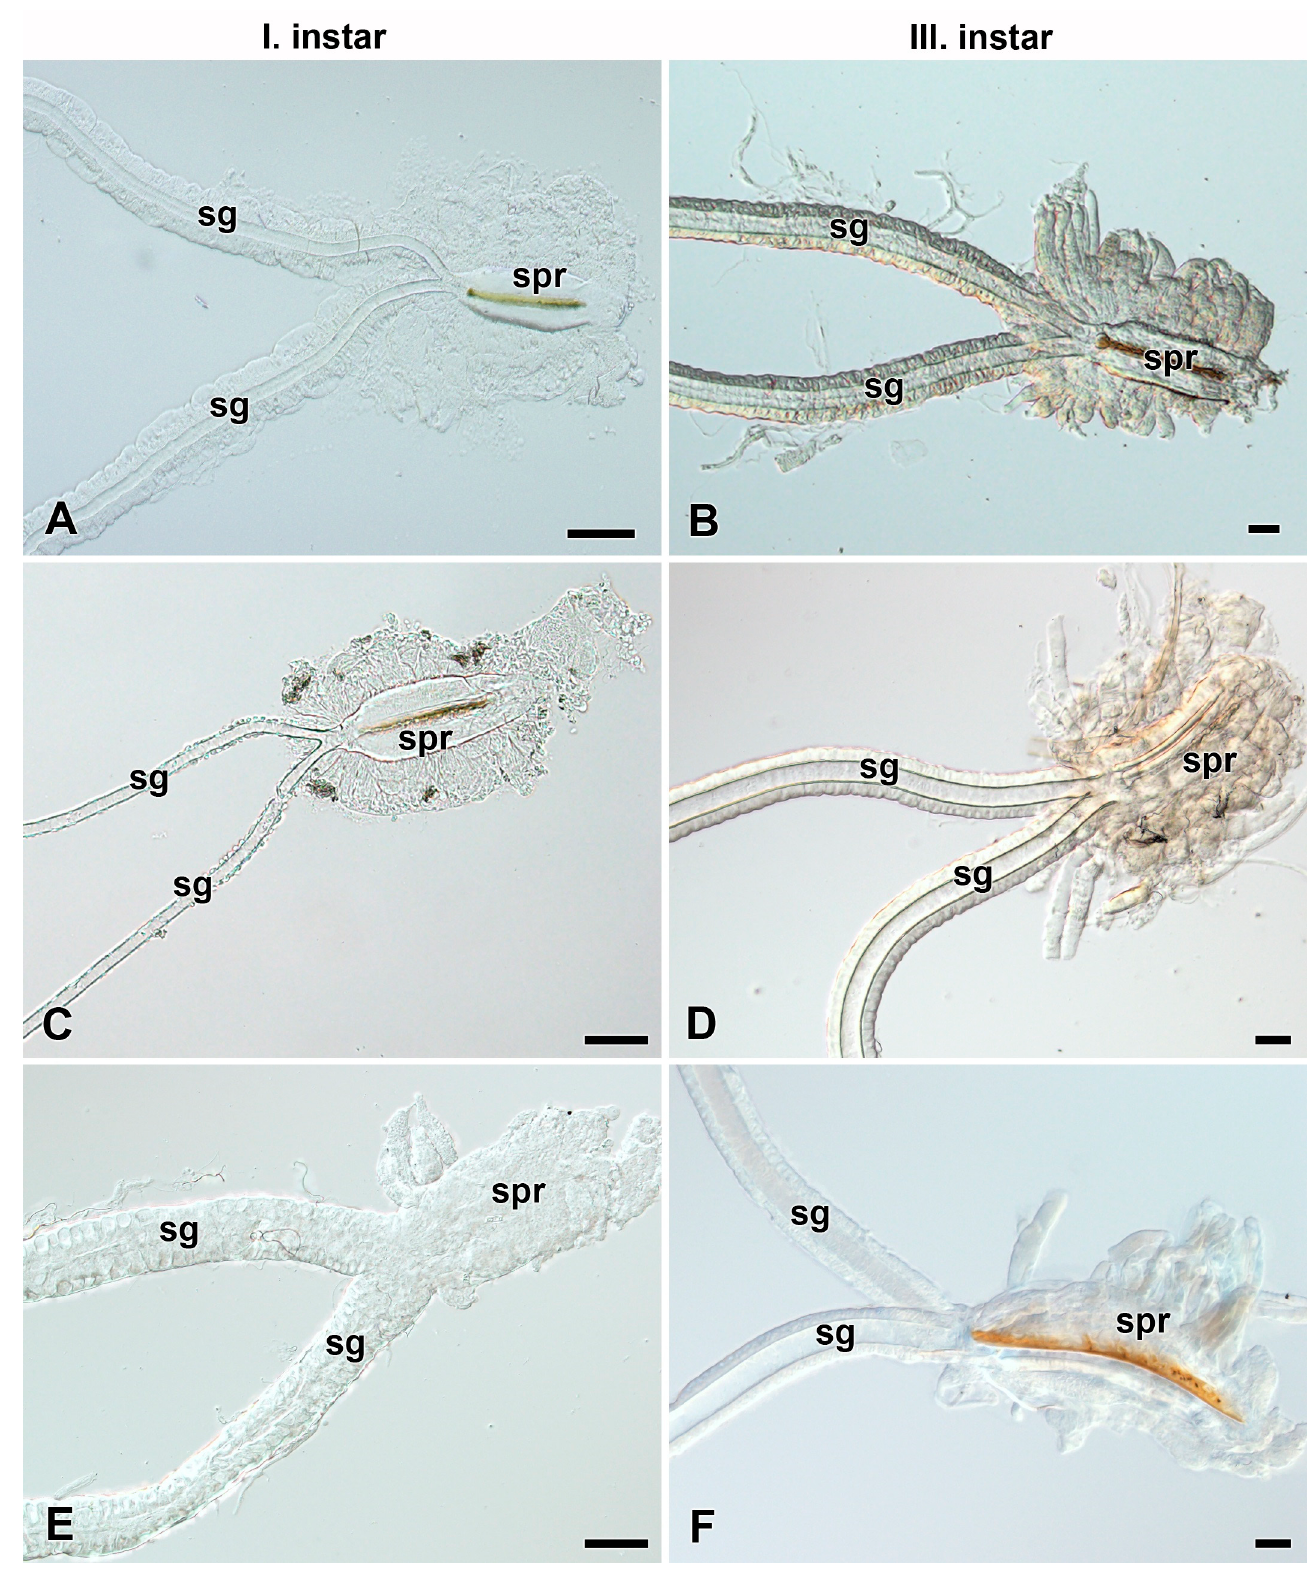
Figure 4. Spinning apparatuses without Filippi’s glands in Saturniidae larvae of the first and third instars. ( A , B ) The cecropia silk moth, Hyalophora cecropia. ( C , D ) The Eri silk moth, Samia cynthia. ( E , F ) The Atlas moth, Attacus atlas. Abbreviations: Filippi’s gland (Fg), silk gland (sg), and silk press of the spinning apparatus (spr). Scale bars: 100 μ m.